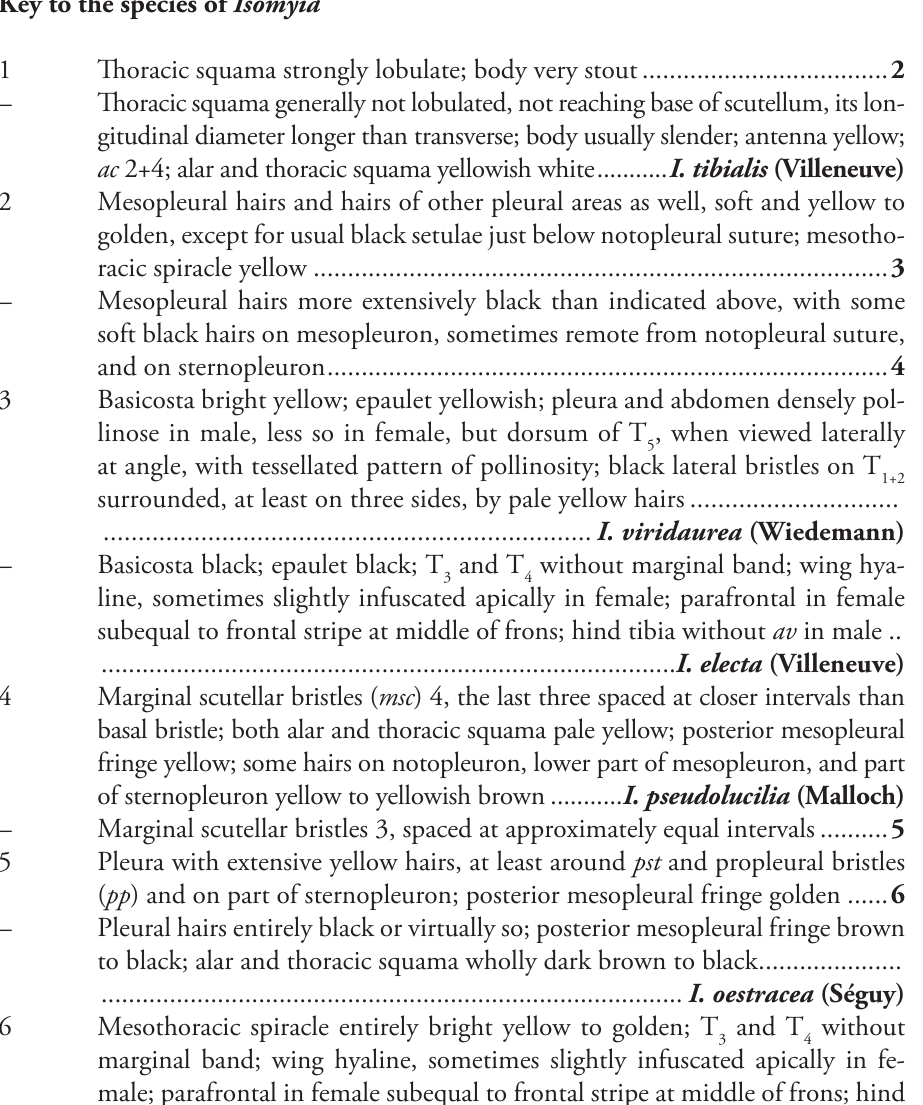
– Second antennal segment fuscous; mid tibia with 1 p , but without brush of